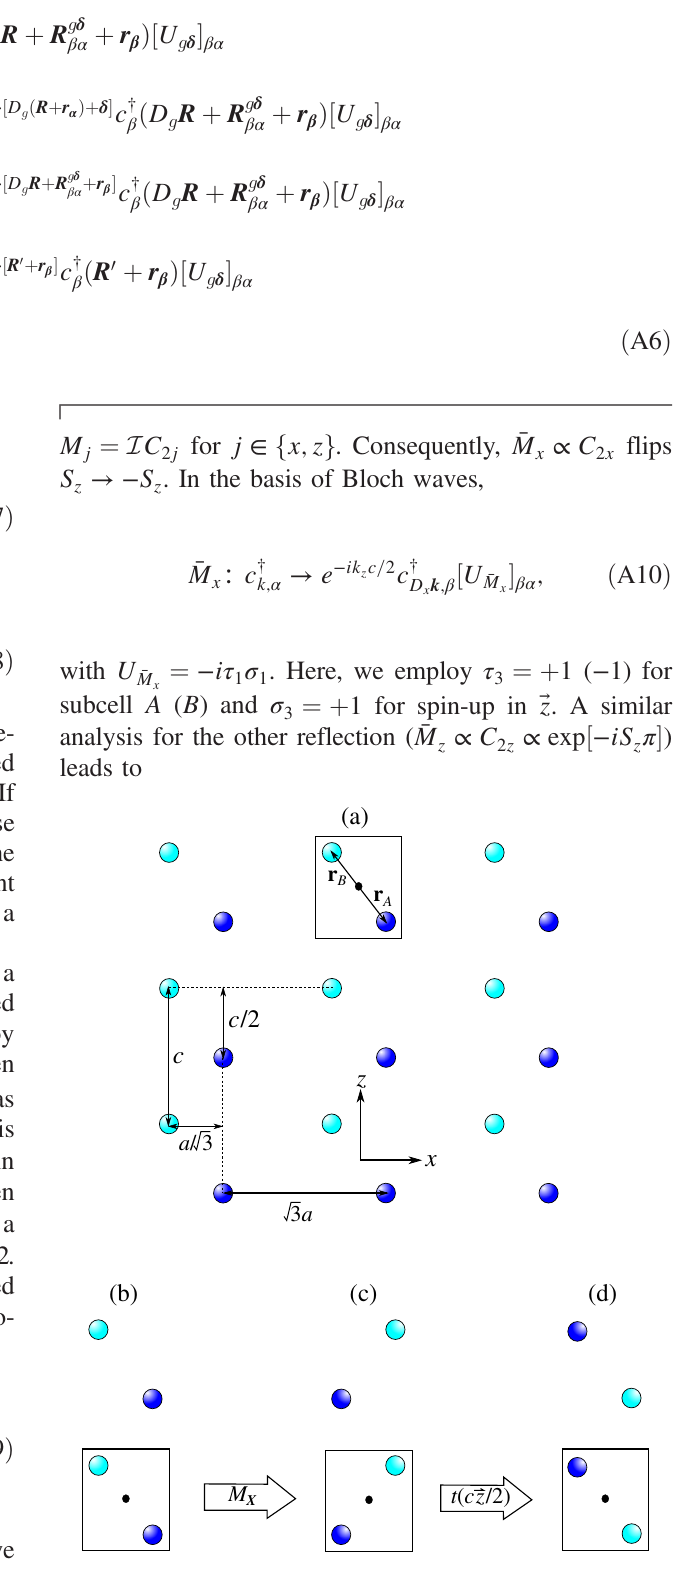
FIG. 11. (a) Simple example of a 2D nonsymmorphic crystal. The two sublattices are colored, respectively, dark blue and cyan. Panels (b) – (d) illustrate the effect of a glide